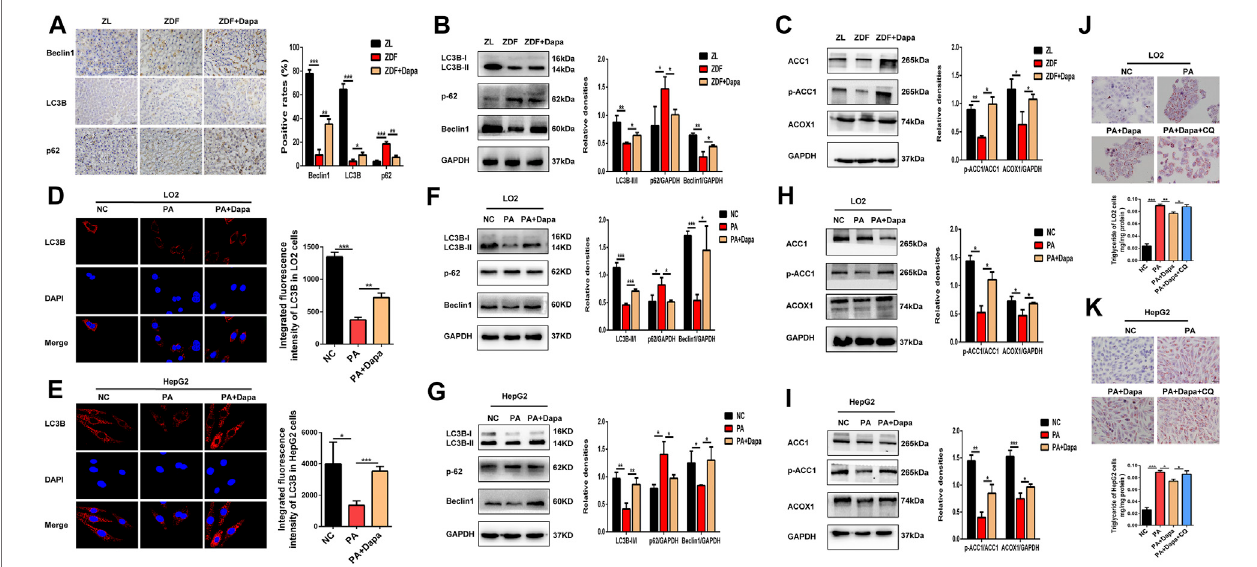
FIGURE 4 | Dapagli fl ozin induces autophagy and regulates fatty acid metabolism in ZDF rats and PA-stimulated LO2 and HepG2 cells. (A) IHC staining detected the expression of LC3B, Beclin-1 and p62 in hepatic tissue. Scale bars: 20 μ m. Data are expressed as the means ± SEM of fi ve animals per group. * p < 0.05, ** p < 0.01, and *** p < 0.001 compared with the ZDF rat group. (B) Western blot analysis evaluated the protein expression levels of LC3B, Beclin-1, and p62 in rats. (C) Western blot analysis detected the expression of ACC1, p-ACC1, and ACOX1 in the livers of rats. (D, E) LC3B immuno fl uorescence staining showed theendogenousLC3BlevelofLO2andHepG2cells. (F,G) Westernblotanalysisdemonstrated theexpression ofLC3B, Beclin-1, and p62 in LO2and HepG2 cells. (H,I) Western blotanalysisdetectedtheprotein expressionofACC1, p-ACC1andACOX1incells. (J, K) LO2and HepG2cellsweretreatedwith 0.3 mMPA,20 μ M dapagli fl ozinand20 µMchloroquine(CQ)for24 h.ThecellswerestainedwithOilRedOandintracellularTGwasquantitativelyanalyzed.Scalebars:20 μ m.Dataare expressed as the means ± SEM from three independent experiments. * p < 0.05, ** p < 0.01, and *** p < 0.001.